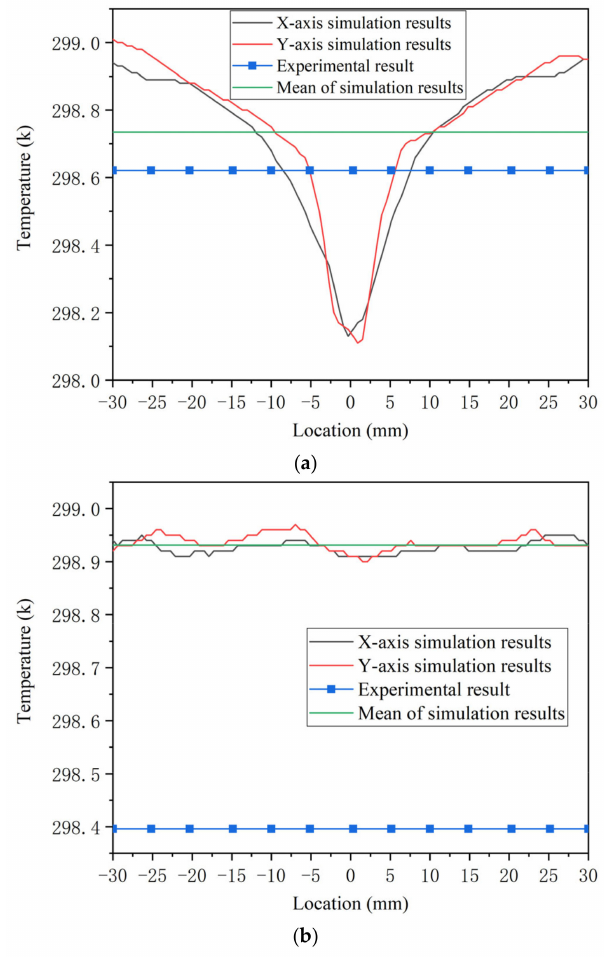
Figure 7. Comparison of axial temperature changes and mean values at the outlet position of the susceptor at cross angles of ( a ) 10 ◦ and ( b ) 15 ◦ .